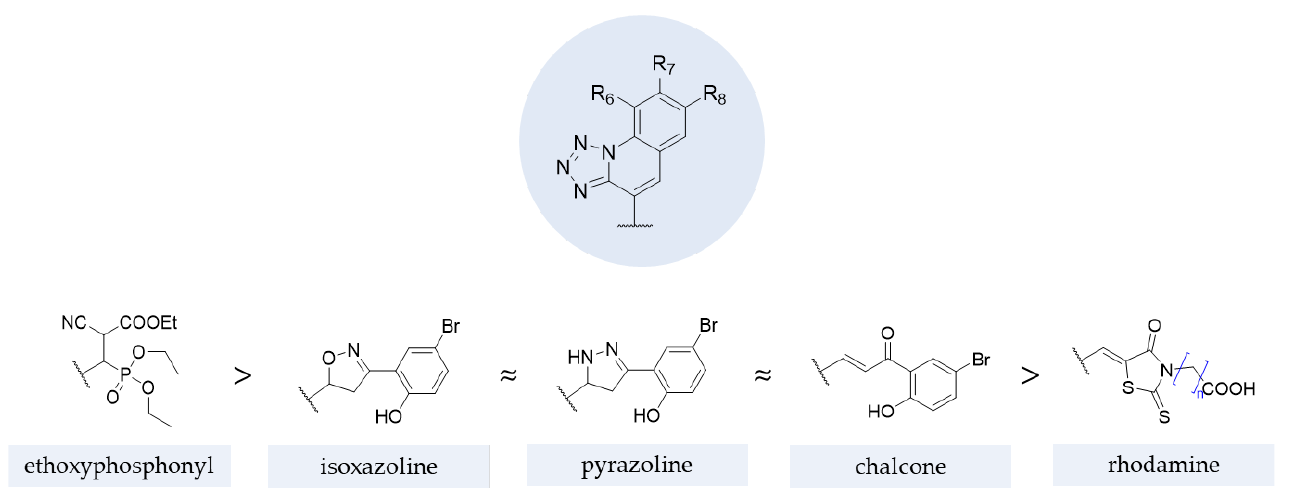
Figure 27. Impact of different moieties on the antifungal activity of the represented scaffold [104– 107].